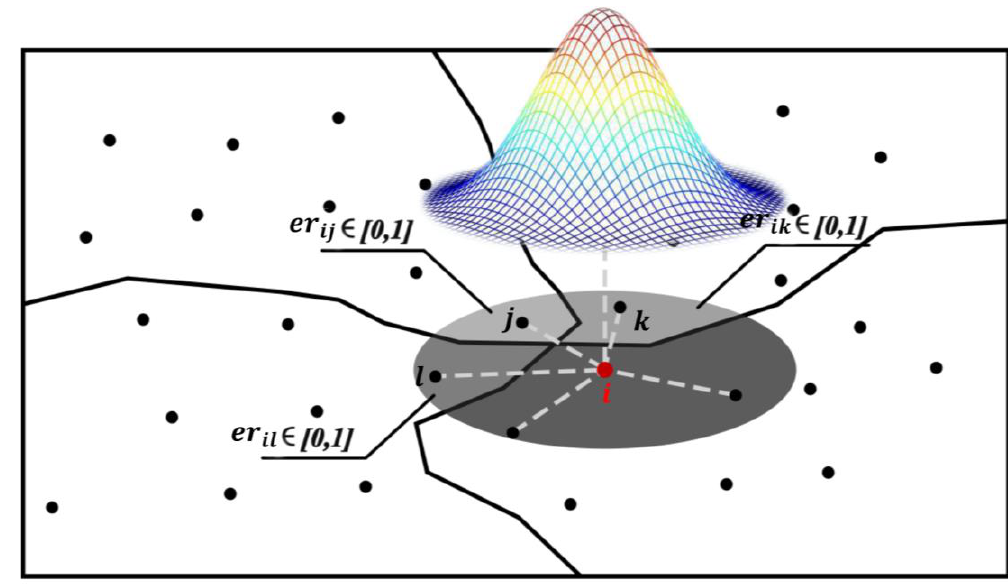
Figure 2. Calculation diagram of E-RGWR regional education impact factors.